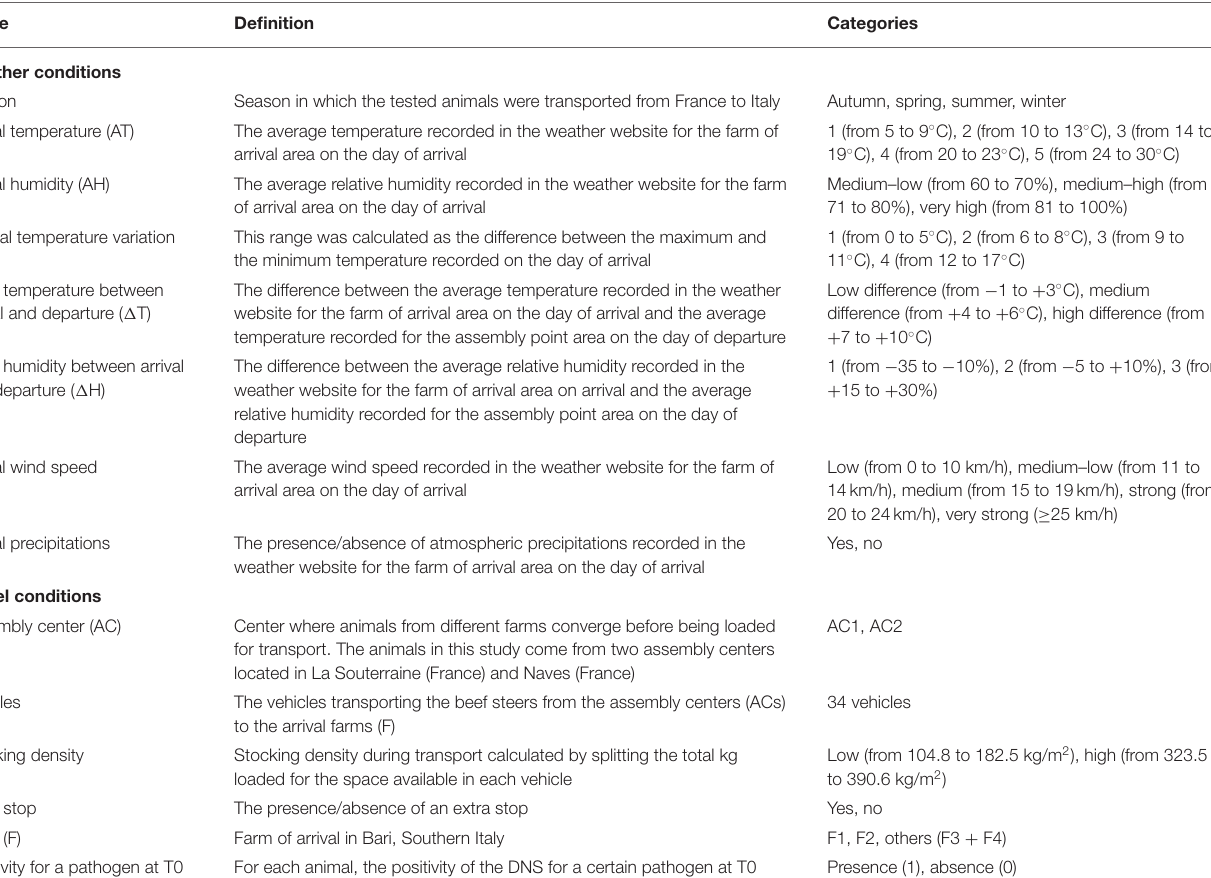
TABLE 1 | Weather and transport conditions considered as predictive variables, with their definitions and categories, during a 1-year cross-sectional study in beef steers shipped from France to